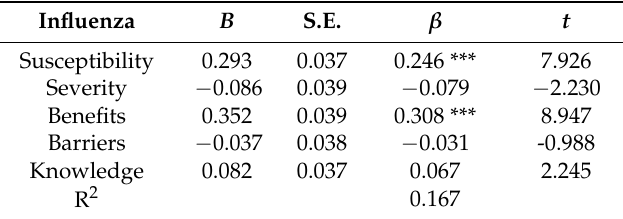
Table 3. Regression of Perceived Susceptibility, Severity, Benefits, Barriers, and Knowledge on the Likelihood of Getting Influenza Vaccine.